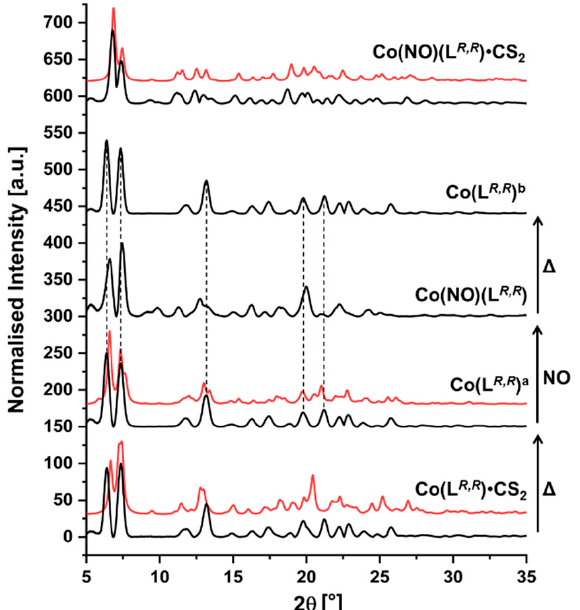
Figure 3. Series of PXRD patterns for an enantiomorphic phase of the CS 2 solvate, before and after desorption of CS 2 , followed by the product of NO chemisorption and subsequent NO desorption. Top pattern is of recrystallized Co(NO)(L) as a CS 2 solvate. Note: Black—measured; red—calculated from single crystal structural